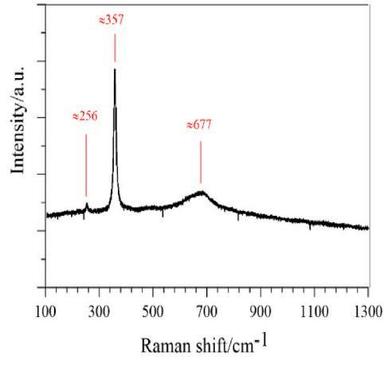
Raman spectra (a, c, e) of CH identified in cracks (red cross) shown in optical micrographs (b, d, f) from samples and CA dosages of: 0% CA (a and b); 1% CA (c and d); and 2% CA (e and f). (For interpretation of the references to colour in this figure legend, the reader is referred to the Web version of this article.)